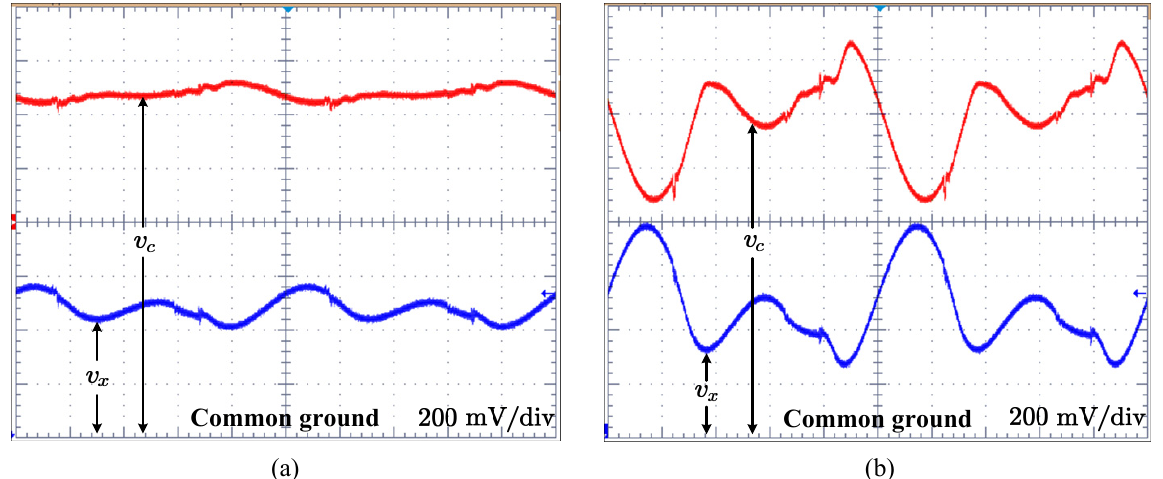
= 0 . 1 µ F , with C c x